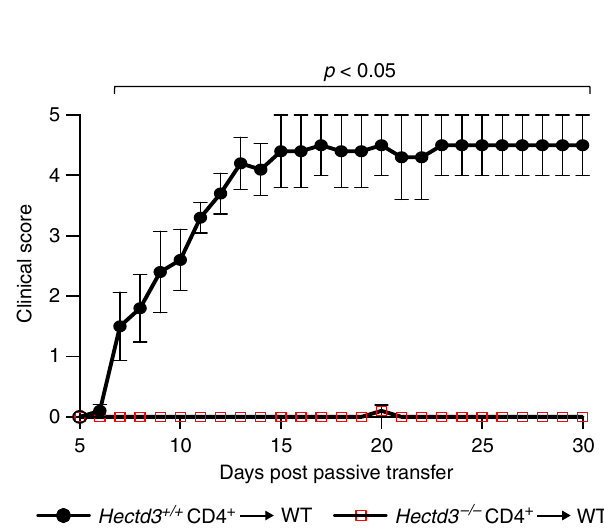
Fig. 4 Hectd3-de fi cient Th17 cells have reduced pathogenicity. EAE disease scores (mean ± SEM) of WT recipients transferred with in vitro IL-23